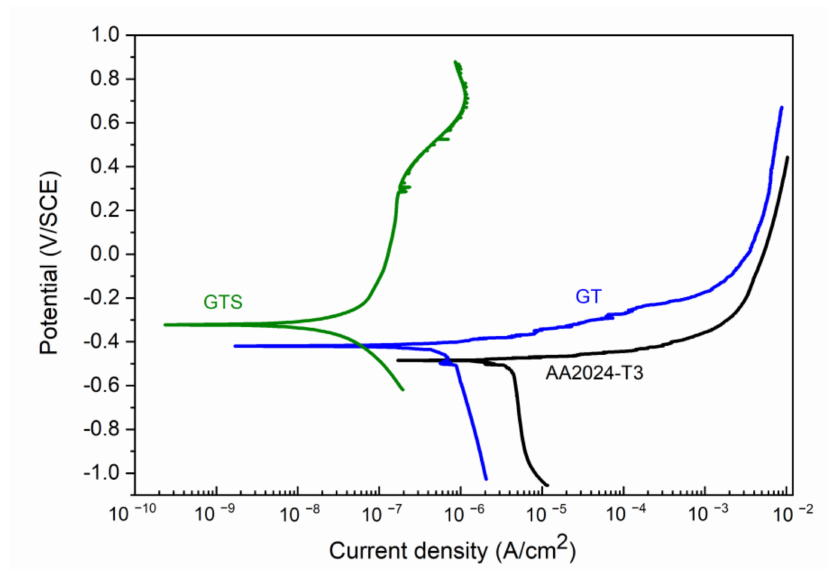
Figure 4. Potentiodynamic polarization curves of bare AA2024-T3 alloy and substrates coated with hybrid sol–gel coatings without and with colloidal SiO 2 nanoparticles denoted as GT and GTS, respectively.